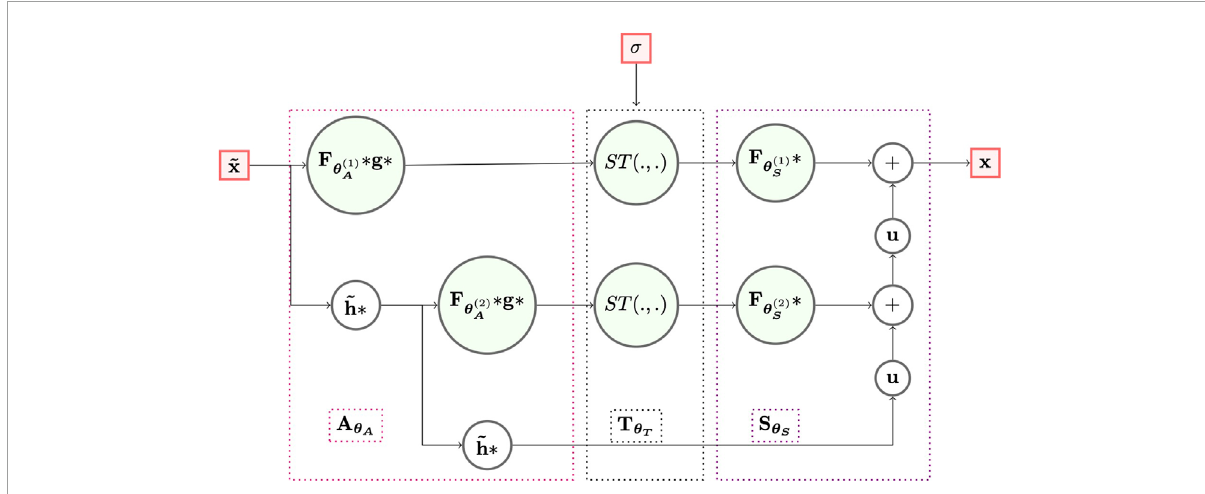
FIGURE 2 Schematic representation of the Learnlet model, with m = 2 scales. Inputs/outputs are represented by the red nodes. The light-green nodes denote functions with learnable parameters. Credit: Ramzi et al. (2021).